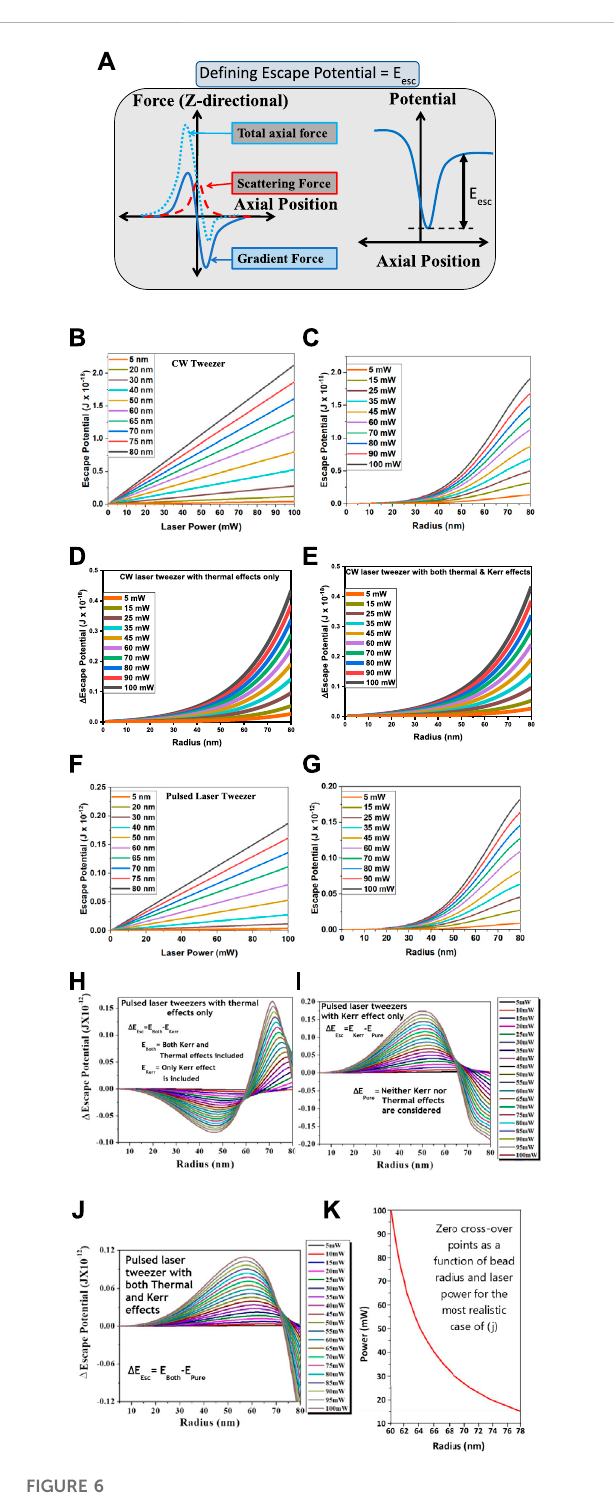
FIGURE 6 A theoretical model of optical tweezers for both CW and pulsed lasers: (A) Schematicoftheforcebalancingusedforthecalculations.For CW tweezers, as shown in (B) , the calculated escape potentials